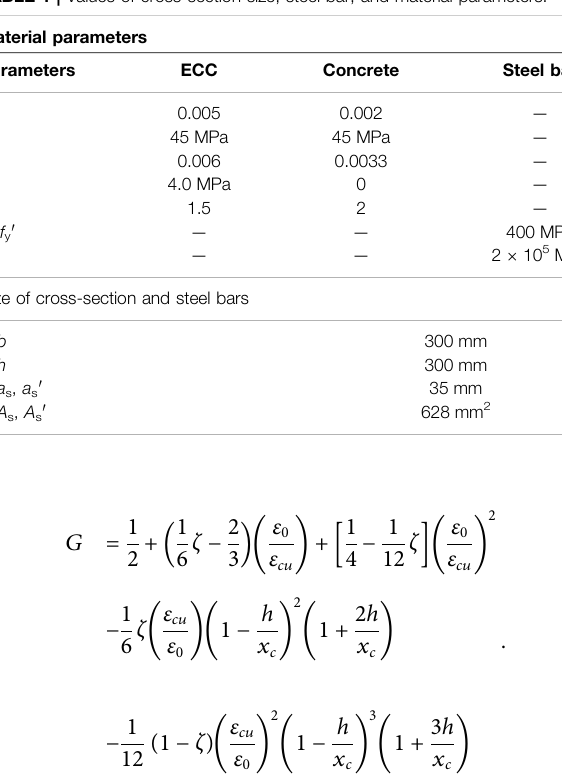
TABLE 1 | Values of cross-section size, steel bar, and material parameters.